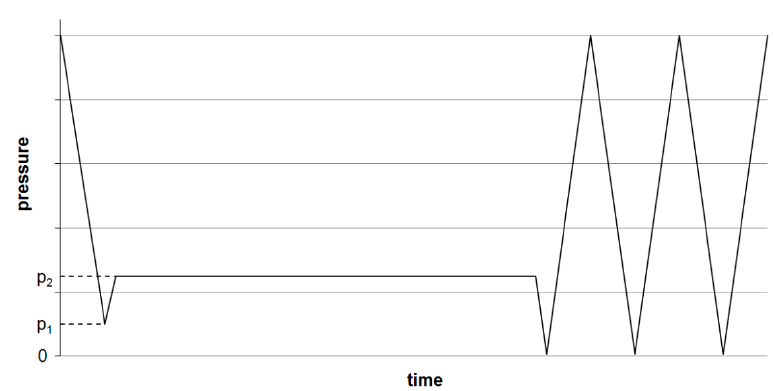
Figure 8. Scheme of the (oxy-)fluorination procedure. Evacuation of the reaction chamber to a pressure p1, inlet of F 2 /N 2 -mixture (10:90 vol %) till p2, maintaining pressure over the reaction time, then multiple evacuations and purging with air till all remaining fluorine is